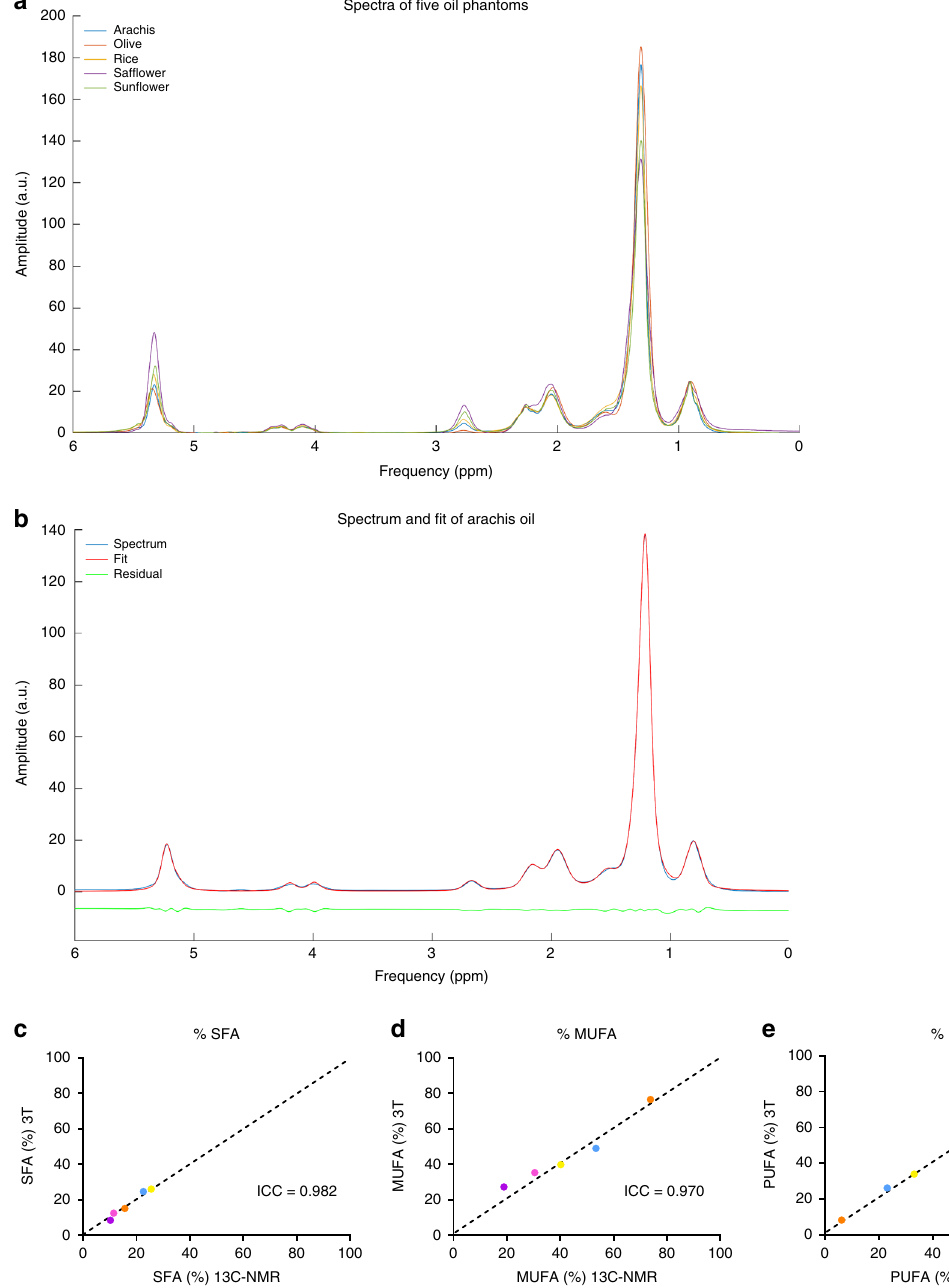
Fig. 1 Validation of 1 H-MRS method in oil phantoms. a Lipid spectra acquired from fi ve different oil phantoms (arachis, olive, rice, saf fl ower, and sun fl ower oil) showing the different lipid proton peaks and their position. b Lipid spectrum and fi t of arachis oil. Correlations between c SFA, d MUFA, e PUFA measured at 3T with 1 H-MRS and measured with high-resolution 13 C-NMR spectroscopy. The intraclass correlation coef fi cient (ICC) is shown in the respective plots (Intraclass